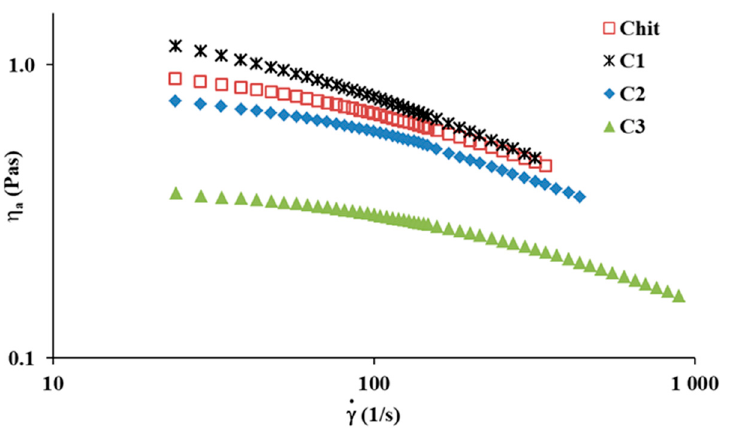
Figure 1. Curves of apparent viscosity vs. shear rate for Chit solution and Chit/clay mixtures at 25 ° C.